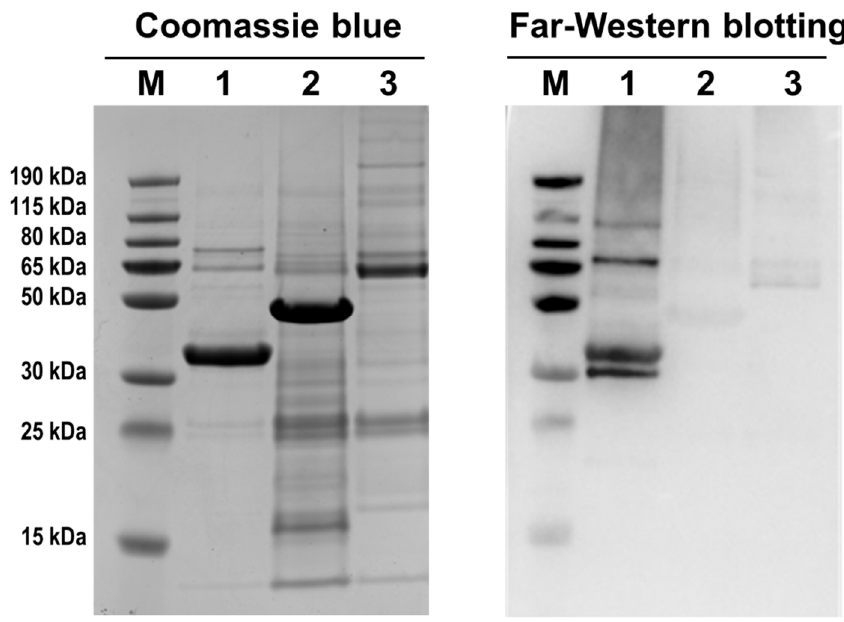
Figure 7. Far-Western blotting of AbxC and its potential target proteins. The recombinant proteins DrOxyR (lane 1), DR_1022 (lane 2), and DrRsr (lane 3) were separated on SDS-PAGE gels and transferred onto PVDF membranes. The purified FLAG-tagged AbxC served as overlay protein. The left panel shows Coomassie blue staining of target proteins, and the right panel shows the corresponding far-Western blot analysis with anti-FLAG antibody.